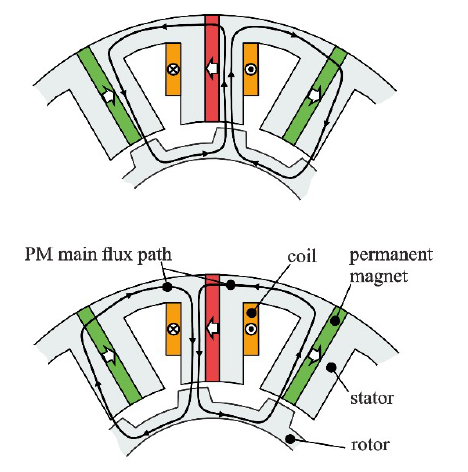
Figure 2. PM flux path depending on the rotor angle